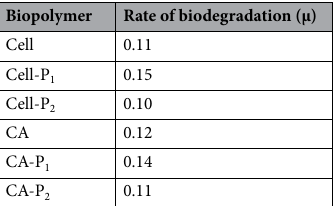
Table 4. Rate of biodegradation of tested